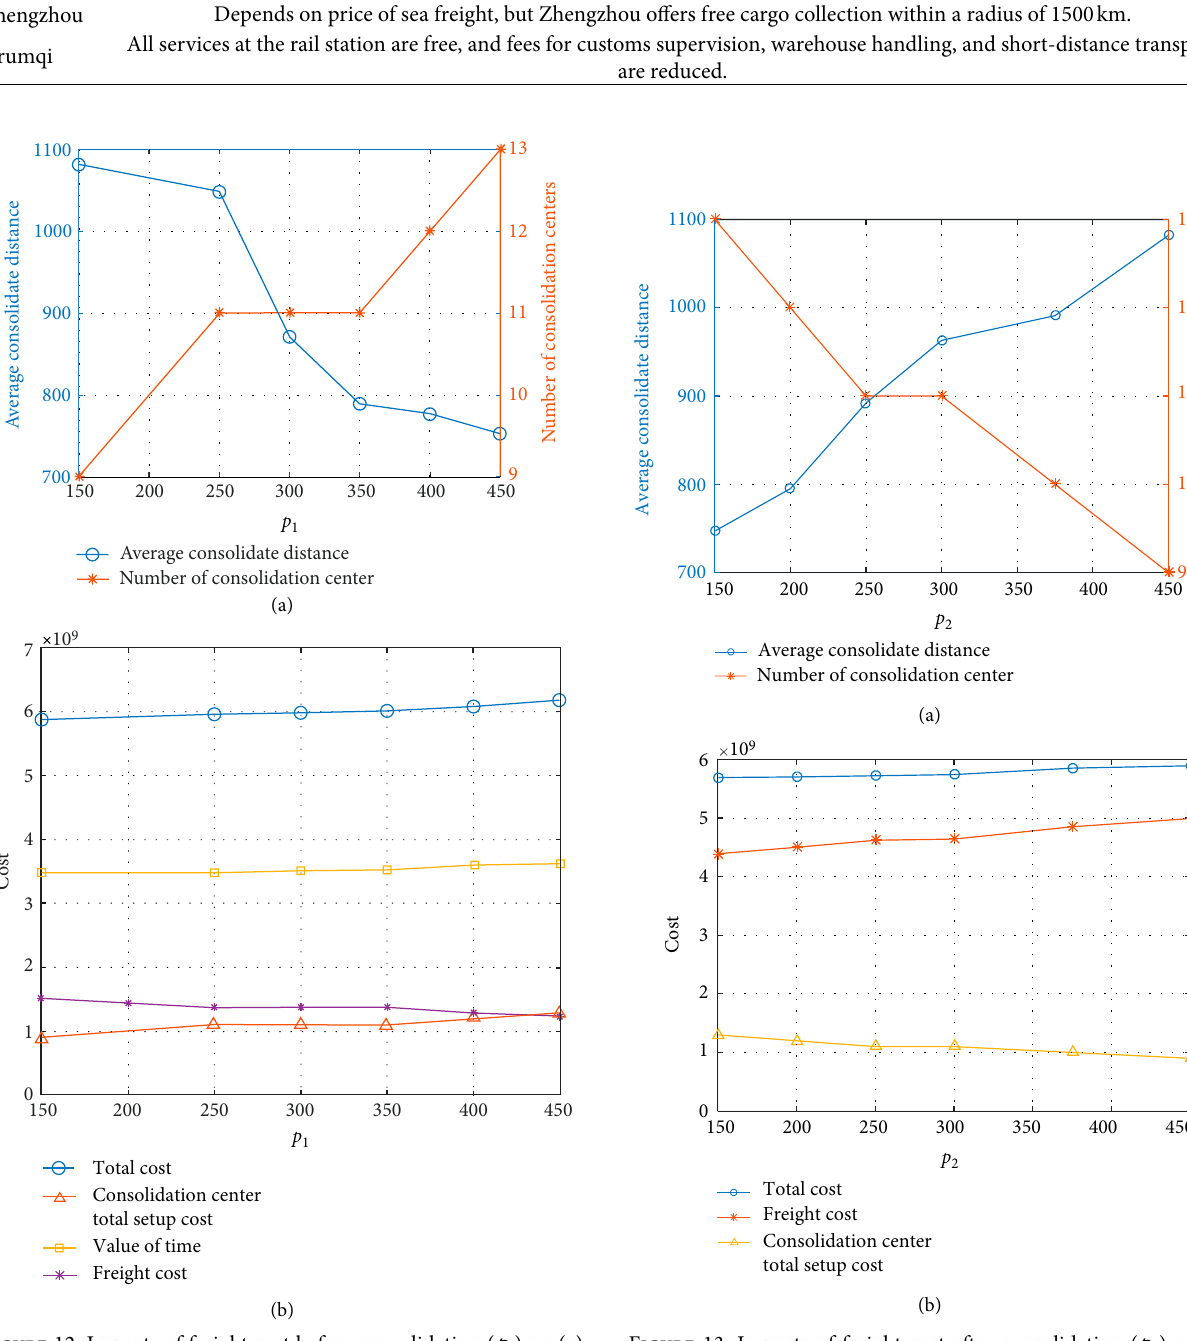
) on (a) 𝑝 2 TC ), freight cost, and consolidation